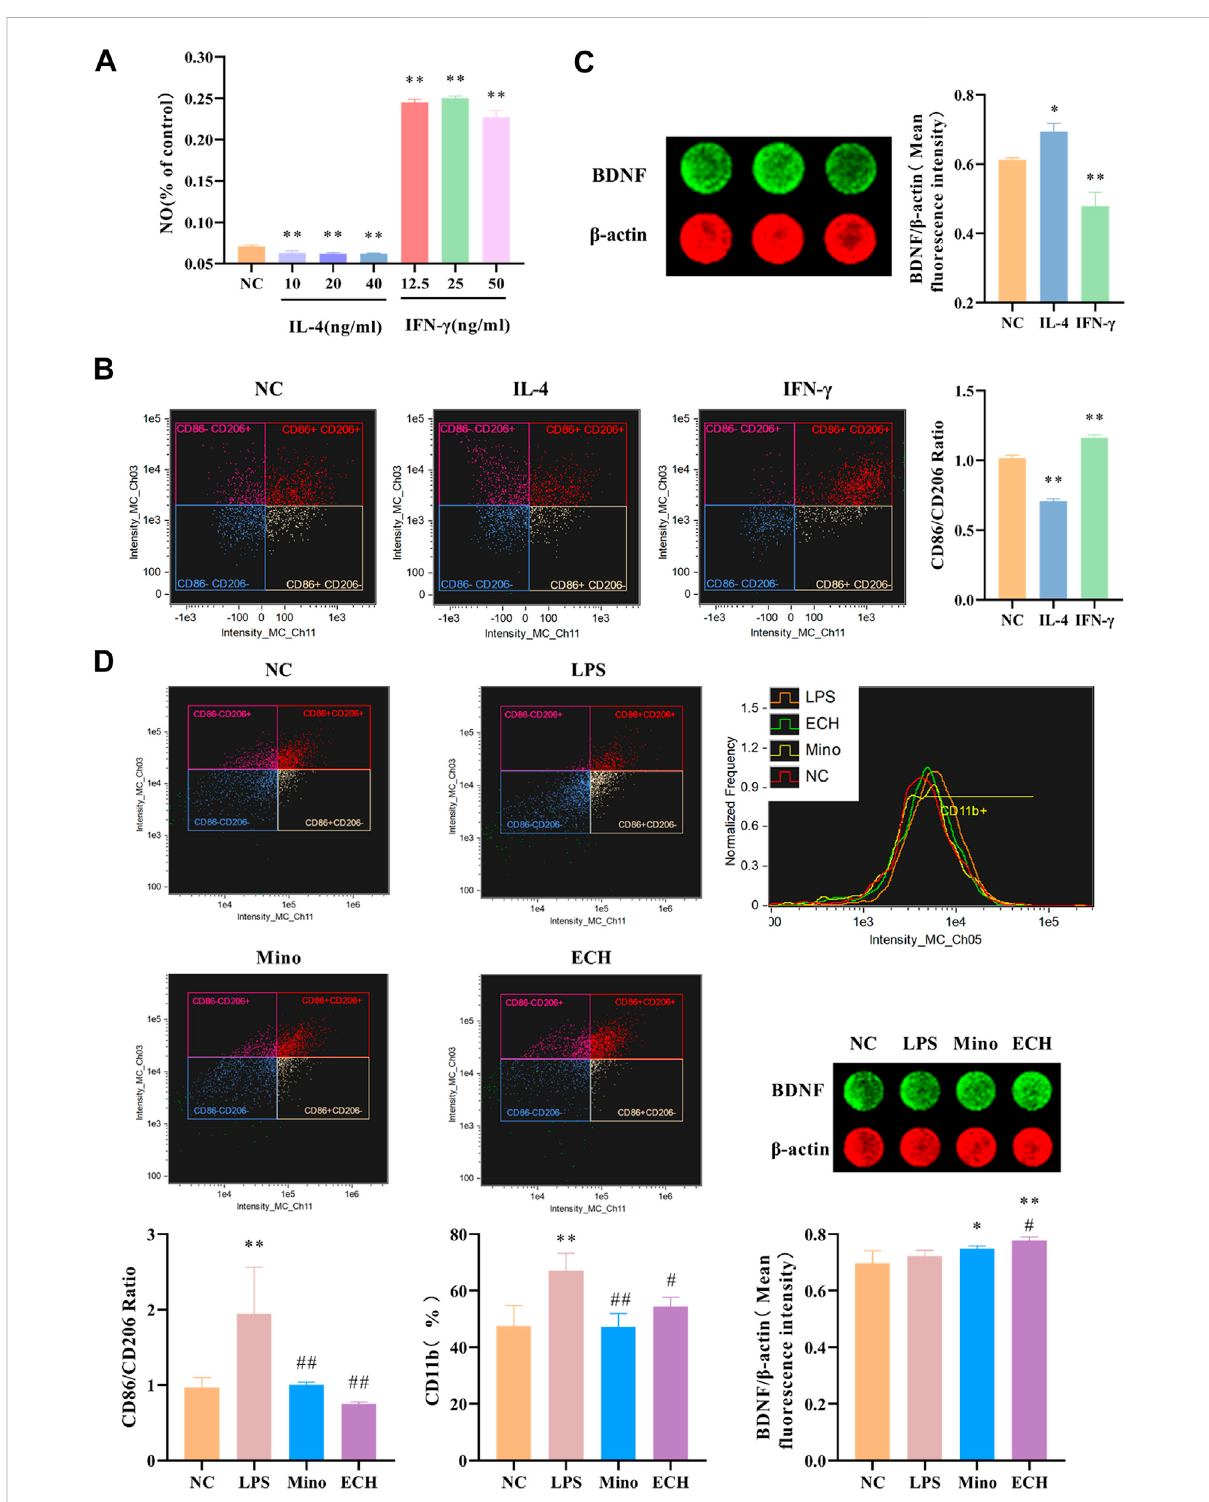
Effects of ECH on M1 and M2 Microglial Markers and BDNF level in LPS induced N9 cells. (A) Effect of IL-4 and IFN- γ on NO level in the supernatantofN9 cells. (B) Effects ofIL-4 and IFN- γ onCD11b, CD86,and CD206 inN9 cells. (C) Effects of IL-4 and IFN- γ on BDNF level inN9 cells. (D) Effects of ECH on CD11b, CD86, CD206 and BDNF levels in LPS induced N9 cells. NC, treated with equal amounts of medium; IL-4, treated with 40 ng/ml IL-4; IFN- γ , treated with 25 ng/ml IFN- γ ; LPS, treated with 1 μ g/ml LPS; Mino, treated with 1 μ g/ml LPS and .1 μ M